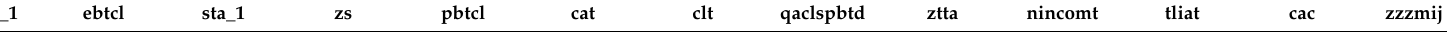
Table A2. Pearson Correlation